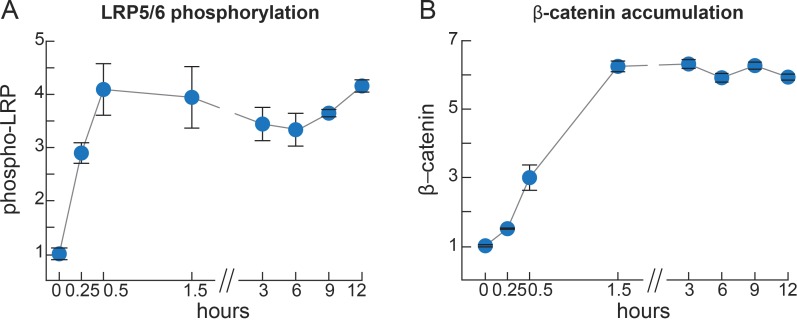
LRP5/6 phosphorylation and β-catenin accumulation are already at steady state at 6 hr after Wnt stimulation.RKO cells were treated with 160 ng/mL Wnt3A for the specified times, and then assayed for phospho-LRP5/6 and β-catenin level by Western blot. Error bars are standard error of the mean from 2 to 4 biological replicates. Data are plotted relative to the sample at time zero, and normalized to the average maximal activation across experiments. The grey lines connect the mean of each time point.